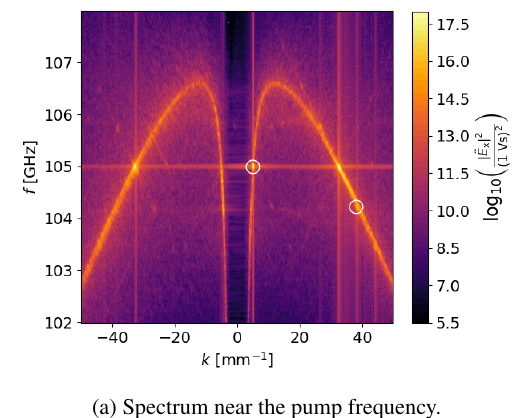
(a) CWT of E x leading up to the UH resonance at t = 30 ns, using the Morlet wavelet as base function. The dotted white line indicates x = x l . The solid yellow line is the solution to warm X-mode propagation[5], and the dashed green line is the solution to the back scattered warm UH mode from equation (2).